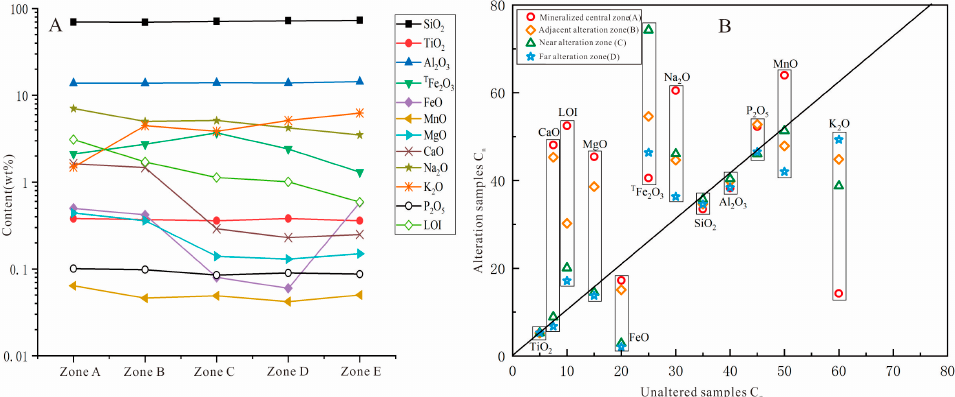
Figure 6. ( A ) Content and ( B ) standardized Isocon diagram of major elements.